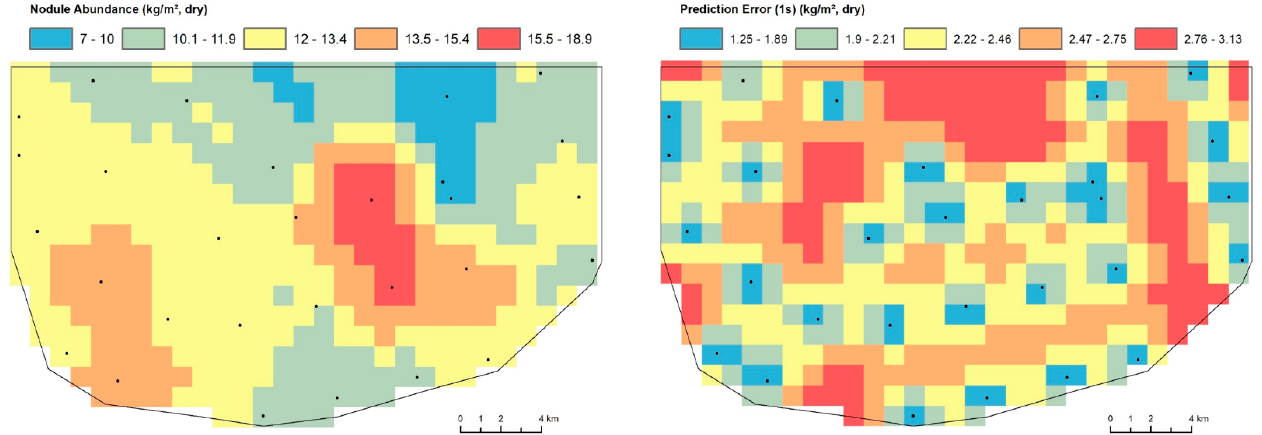
Figure 19. Prediction of nodule abundance in 1-km 2 blocks (1000 m × 1000 m) in PA1-East ( left ) based on ordinary kriging and the 1-sigma prediction error ( right ).